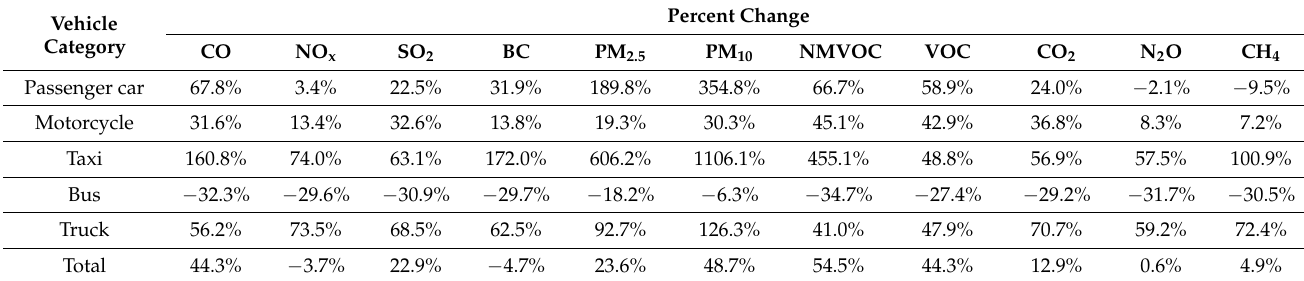
Table 3. Percent change of emissions between the COPERT/Bottom-up and the COPERT/Top-down EI [(Top-down—